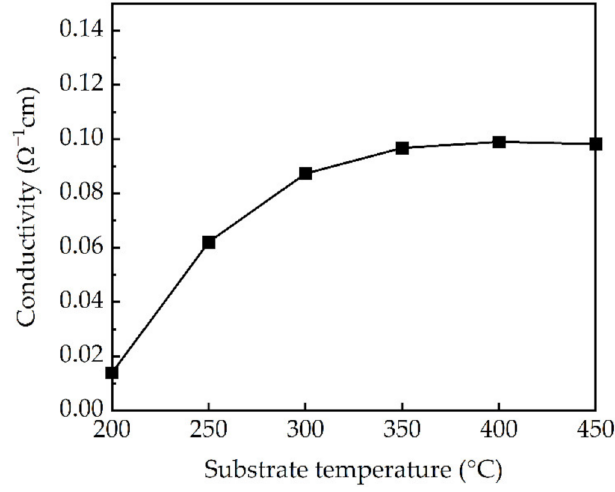
Figure 4. Conductivity of PEALD GaN films deposited at different substrate temperatures.